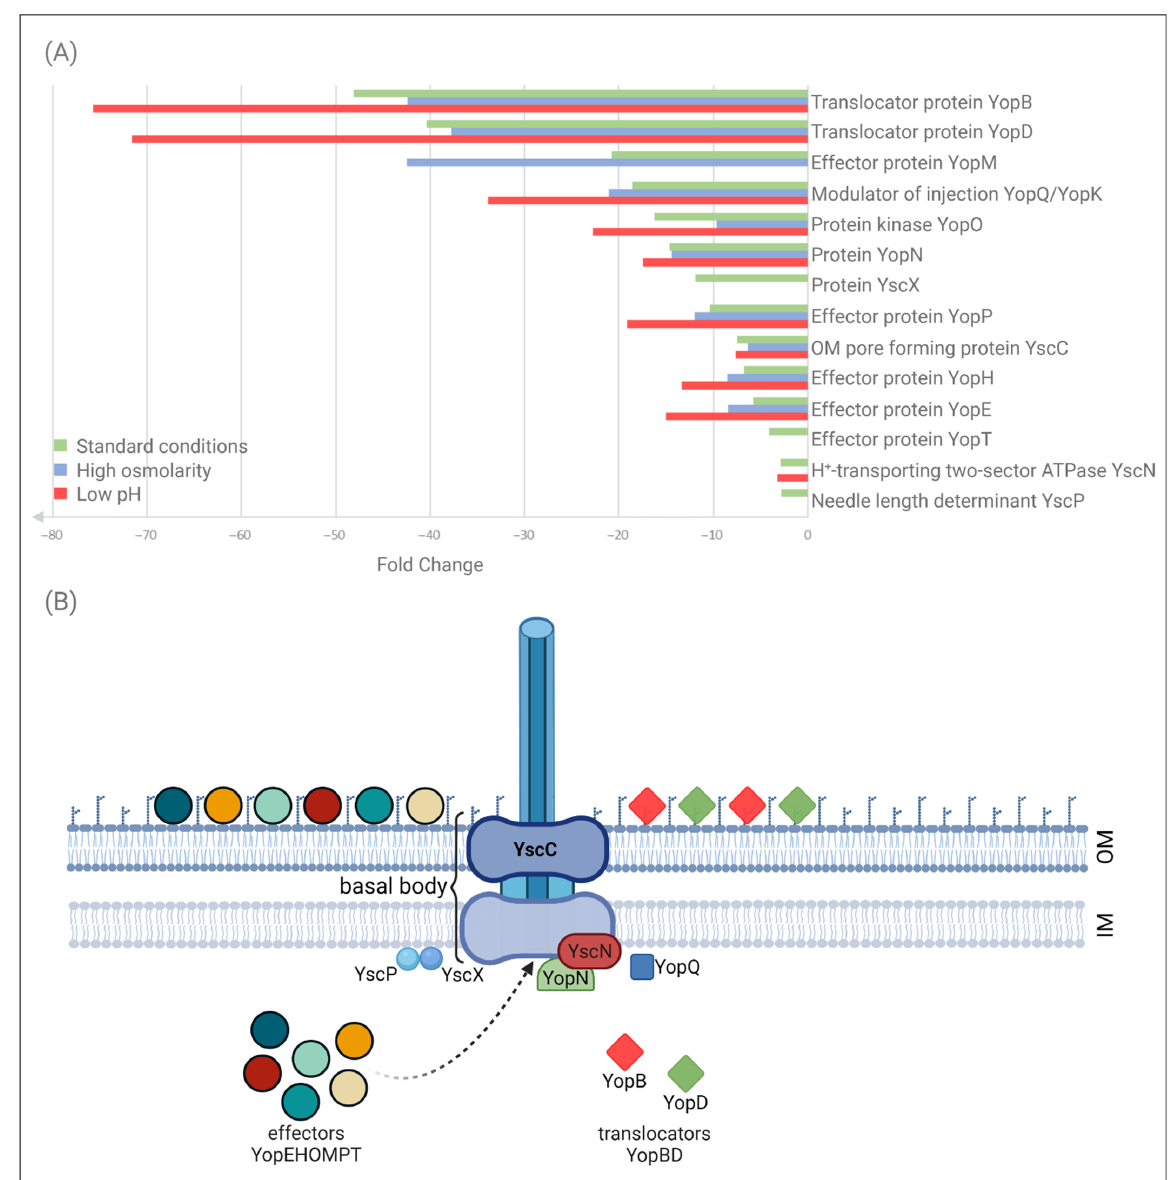
Figure 2. Proteins of the Y. enterocolitica Ysc-Yop T3SS whose abundance differs significantly between wild-type strain Ye9 and ompR mutant AR4. ( A ) The chart shows the AR4:Ye9 protein abundance ratios under different growth conditions. Green indicates standard conditions (LB medium); blue indicates high osmolarity (LB supplemented with NaCl to 386 mM) and red indicates low pH (LB adjusted to pH 5.0), with incubation at 37 °C. ( B ) Diagram of the Y. enterocolitica cell wall showing the Ysc secretory apparatus and its substrates before target cell contact, according to the two-step model of secretion. The proteins displaying increased abundance in the ompR mutant compared with the wild-type strain when grown in LB medium at 37 °C are marked. Protein YscC forms a ring in the bacterial outer membrane (the OM ring) and creates the basal body of the secretory apparatus. YscN, located on the cytosolic face of the basal body, is the ATPase driving the secretion of substrates. YscP and YscX are categorized as early secretion substrates: YscP participates in needle assembly and as a substrate specificity switch, YscX is required for the export of early substrates. YopN acts to block Yops export. YopQ may interact with YopD to influence the function of the injectosome. YopB and YopD are translocators. YopEHOMPT is the effector Yops. Created with BioRender.com (accessed on 24 February